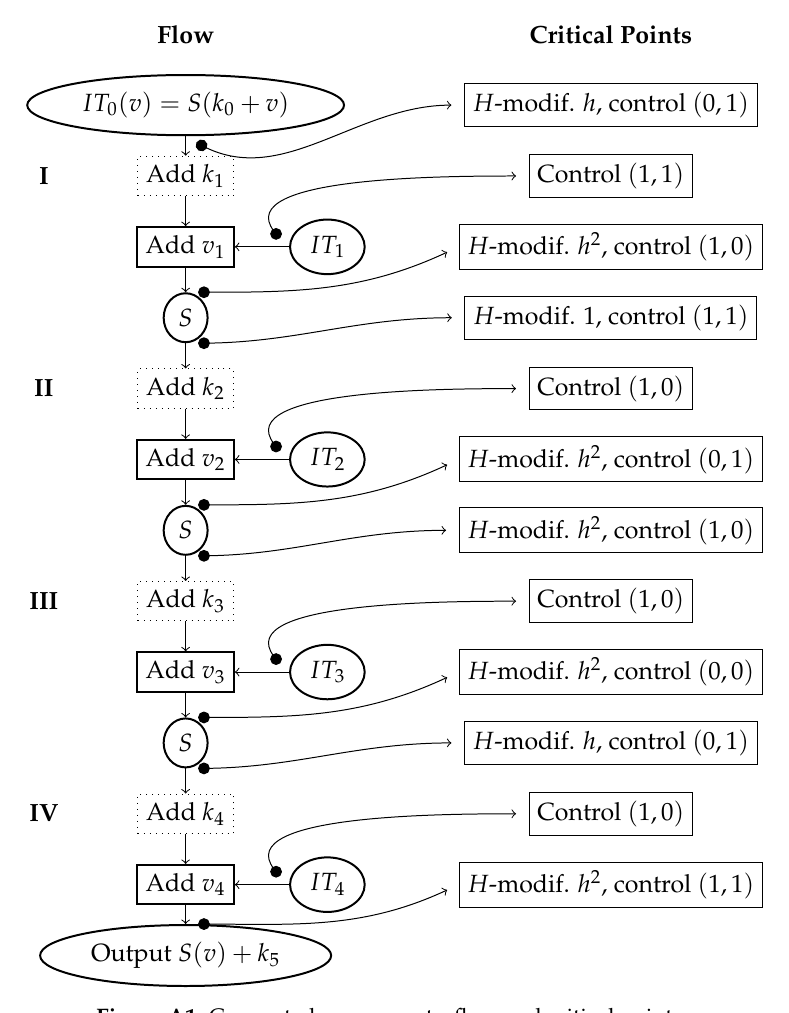
Figure A1. Connected components, flow and critical